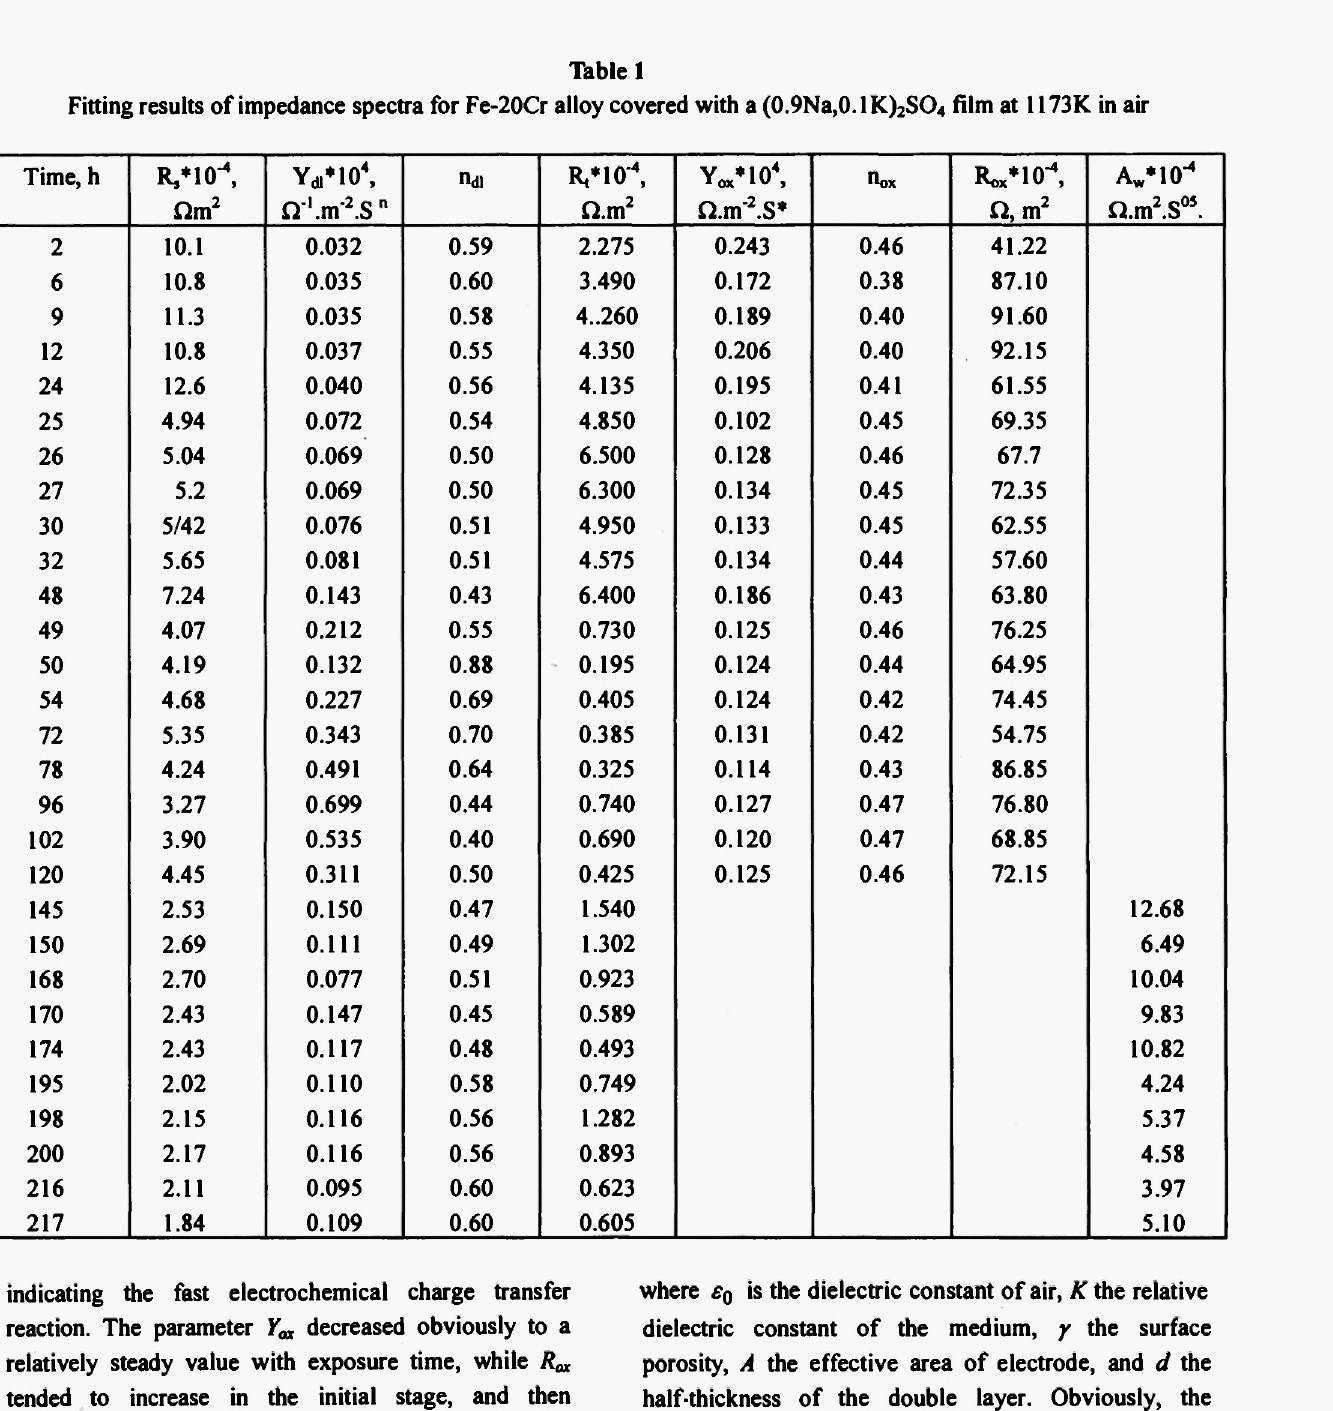
Fitting results of impedance spectra for Fe-20Cr alloy covered with a (0.9Na,0.1 K) 2 S0 4 film at 1173K in